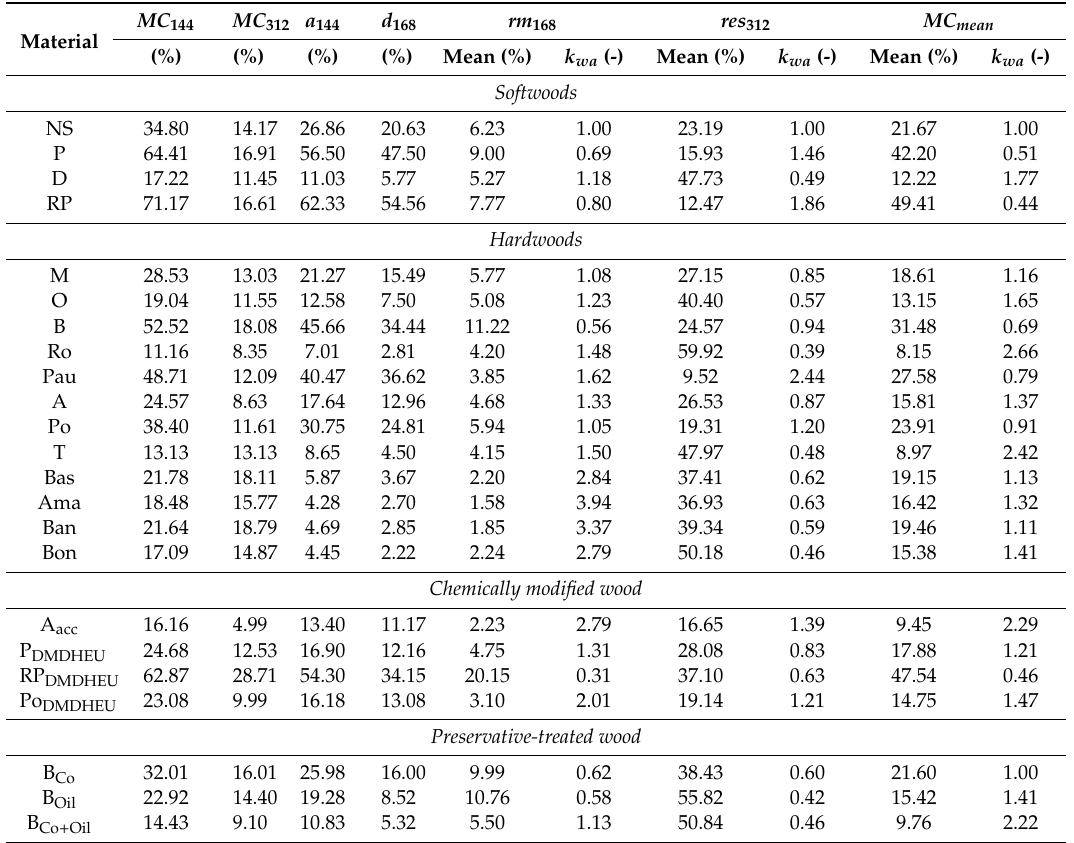
Table 3. Moisture content at the end of absorption ( MC 144 in %) and desorption cycle ( MC 312 in %), amount of absorbed moisture after 144 h ( a 144 in %), amount of desorbed moisture after 168 h ( d 312 in %), residual moisture content ( rm 168 in %), residue ( res 312 in %) and mean MC ( MC mean ) in floating tests (50 (ax.) × 50 × 25 mm 3 ) according to